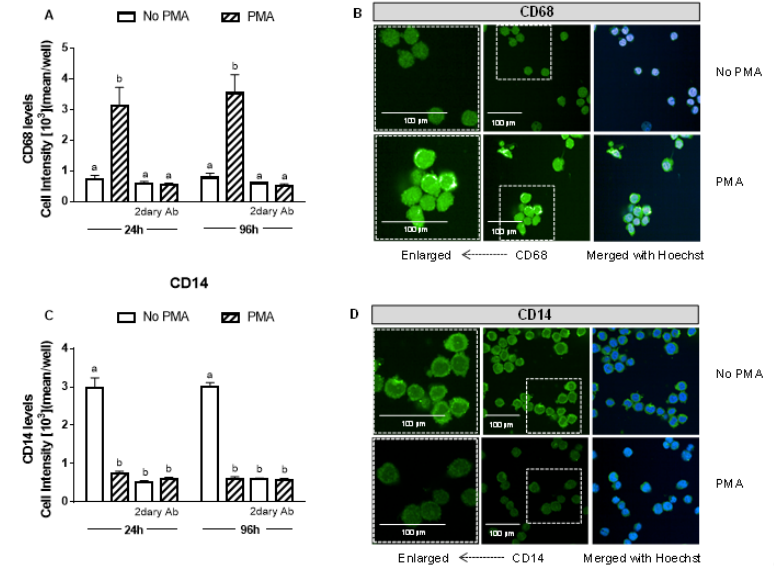
Figure 1. PMA induces monocyte differentiation into macrophages. After 24 and 96 h of differentiation with 25 ng/mL PMA ( A , B ), CD68 and ( C , D ) CD14 levels were measured and compared to the non-treated THP-1 cells. CD68 and CD14 levels were detected by immunofluorescence using a confocal imaging system (Opera Phenix, Perkin Elmer). Images were acquired with a 20× water objective. Staining intensity levels were analyzed using Harmony software (Perkin Elmer). Nuclei and cytosol were identified through Hoechst (at 405 nm) and CellMask (at 655 nm) staining, respectively. Scale is shown as 100 μ m. White dotted frames indicate the section of the image that was enlarged. CD14 (cluster of differentiation 14); Values with different superscript letters (a and b) indicate significant differences ( p < 0.05) between groups. For all bars with the same letter, the difference between the means is not statistically significant. CD68, cluster of differentiation 68; PMA,